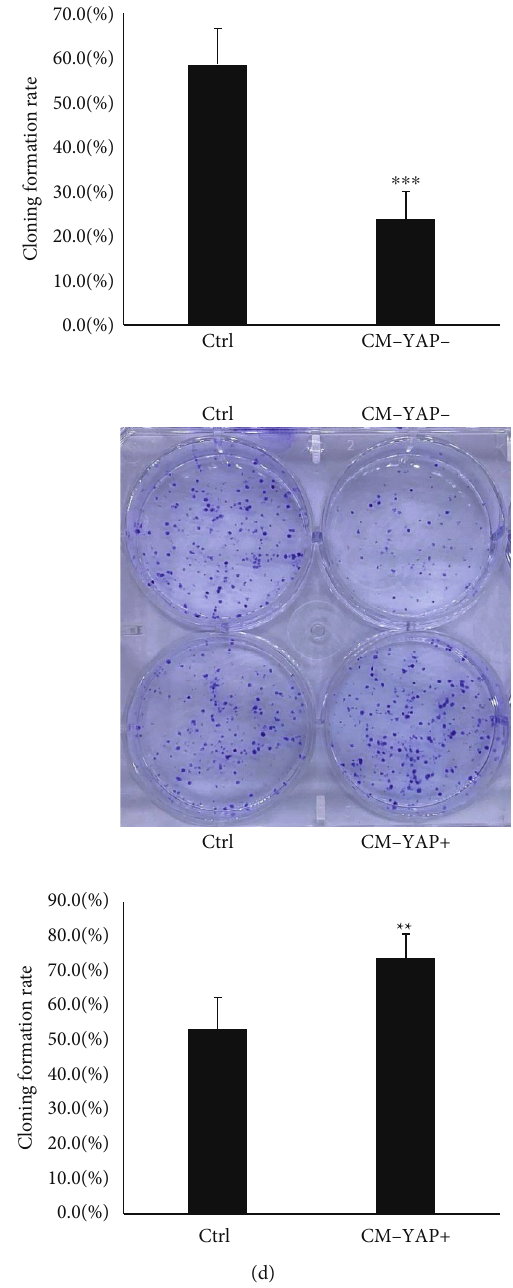
Figure 1: Conditioned medium from YAP overexpressed breast cancer cells promoted tube formation, migration, and proliferation of human umbilical vein endothelial cells (HUVECs). (a) MDA-MB-231 cells were transfected with YAP CRISPR/Cas9 KO plasmid (YAP KD) and YAP CRISPR activation plasmids (YAP OE), YAP expression was detected by Western blot. (b) After starved from FBS for 16hr, human umbilical vein endothelial cells (HUVECs) were treated with conditioned medium obtained from YAP knock down (CM- YAP-) and overexpressed (CM-YAP+) breast cancer cells for 12hr. The total segment length and total branching length from tube formation assay are quanti fi ed with means ± SD from six independent representative fi elds. ∗∗∗ p < 0 : 001 . (c) Migration of HUVECs with di ff erent conditioned medium treatment was conducted by Transwell assay. The results are from three independent experiments. ∗∗ p < 0 : 01 , ∗∗∗ p < 0 : 001 . (d) HUVECs were treated with di ff erent conditioned medium. Cell proliferation was tested by plate cloning formation. ∗∗ p < 0 : 01 . The cloning formation rate is quanti fi ed with mean ± SD from six independent wells. ∗ p < 0 : 01 , ∗∗∗ p < 0 : 001